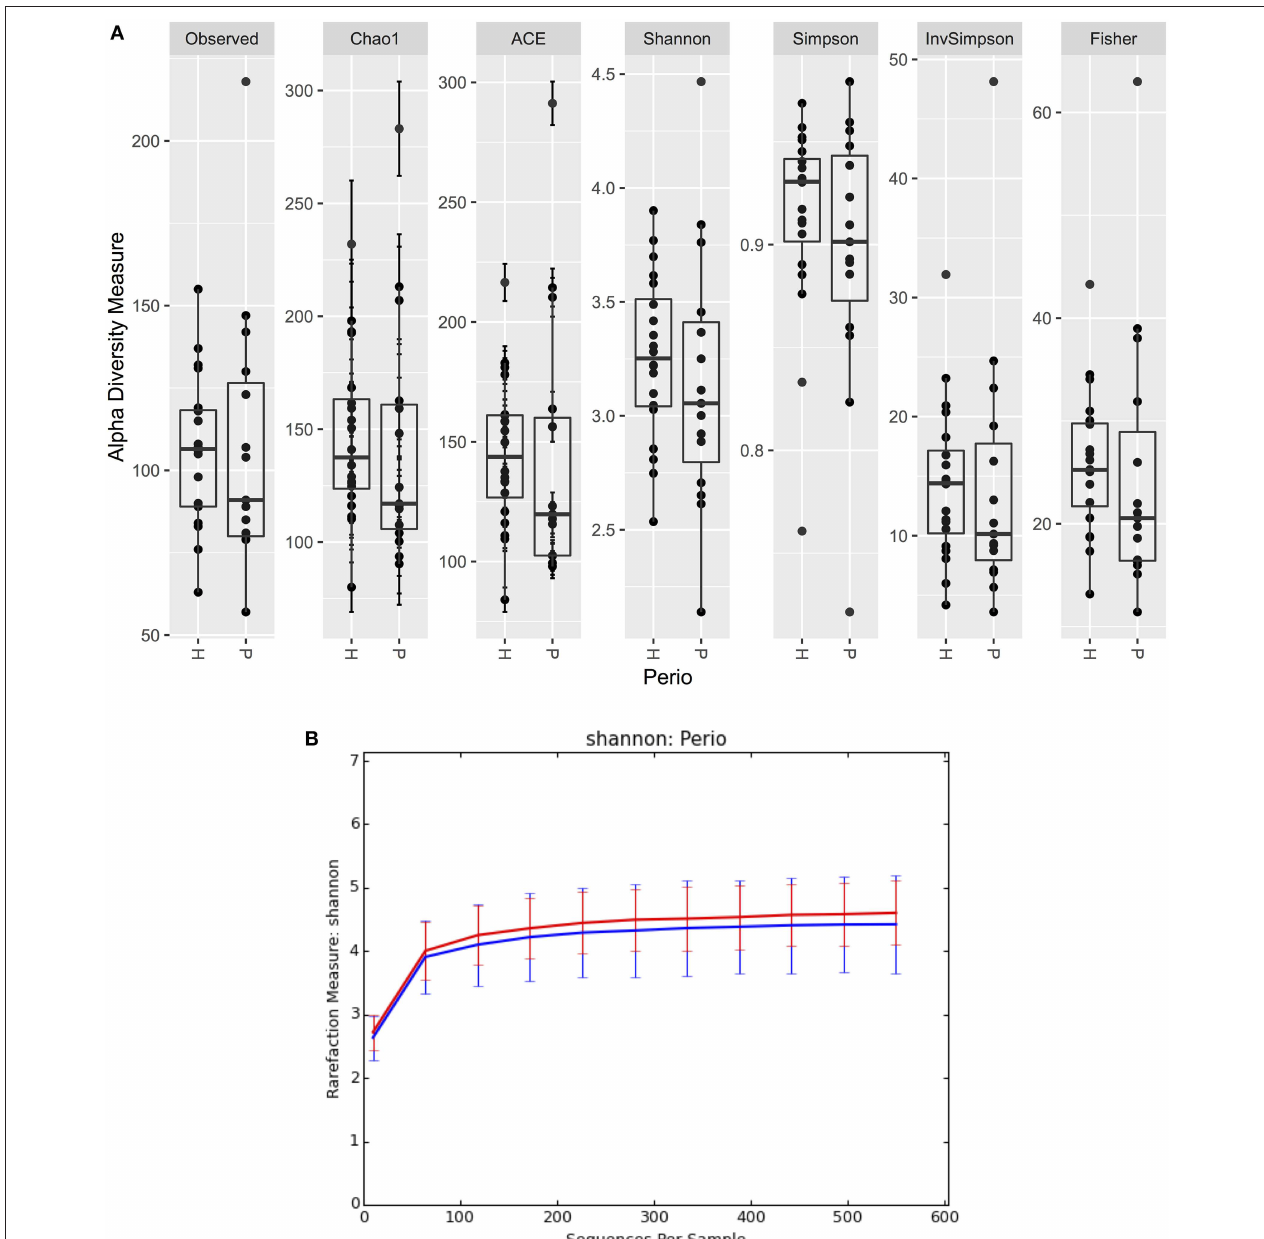
FIGURE 3 | (A) Boxplots of alpha diversity measures in P and H groups. (B) Rarefaction plot of Shannon alpha diversity in P and H groups. P, blue color; H, red color.